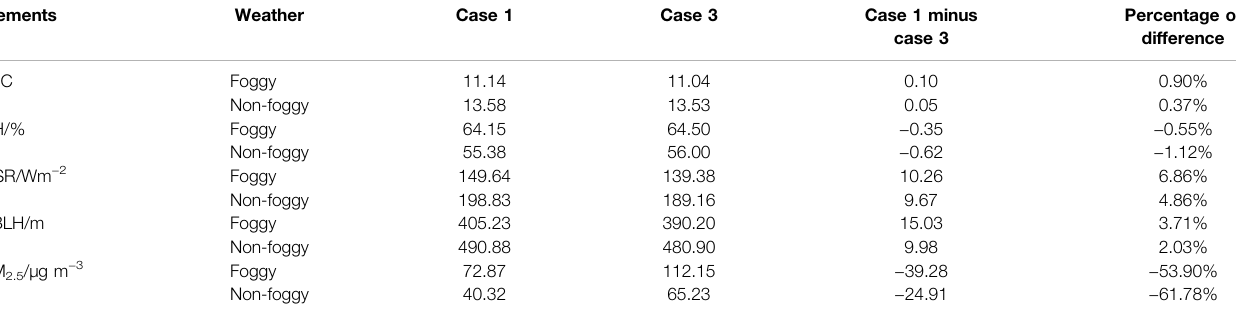
TABLE 7 | Simulated meteorological parameters and pollutants on foggy and non-foggy days caused by emission reduction from 2015 to 2021. Elements